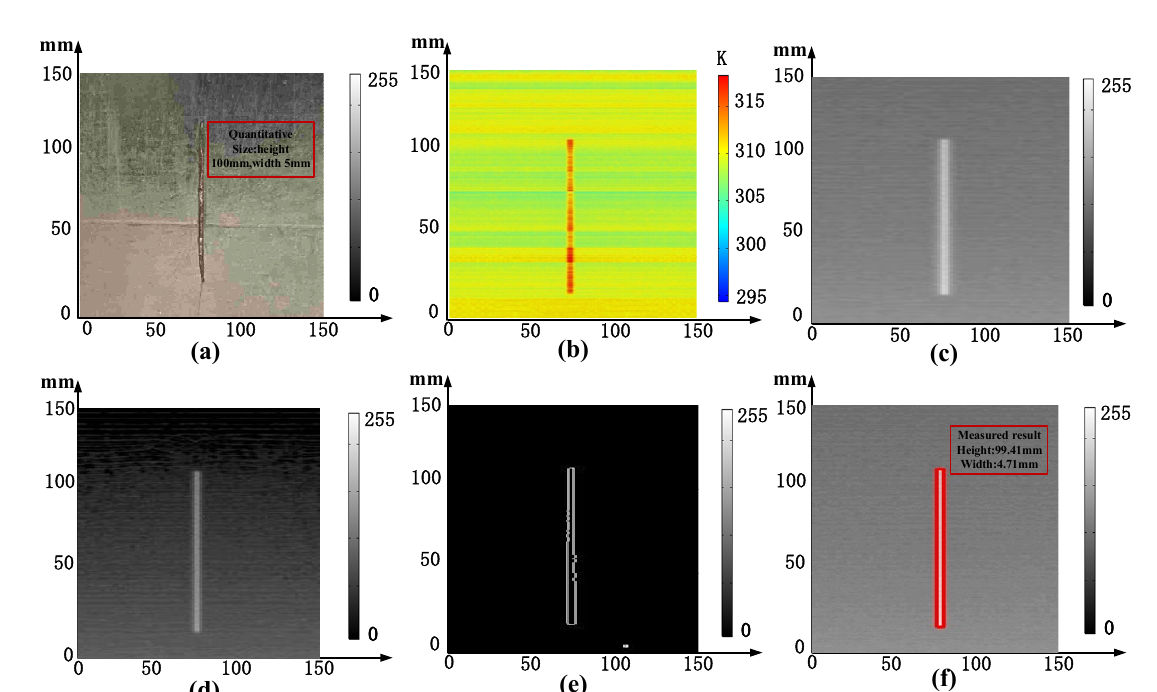
Figure 11. Test results of a mini-crack detection. ( a ) The original image is taken with the conveyor belt at rest; ( b ) mini-crack feature image; ( c ) gray mini-crack feature image; ( d ) image enhancement; ( e ) threshold segmentation; ( f ) mini-crack size. Table 1. Measured values of three sizes of mini-cracks based on laser excited thermography.